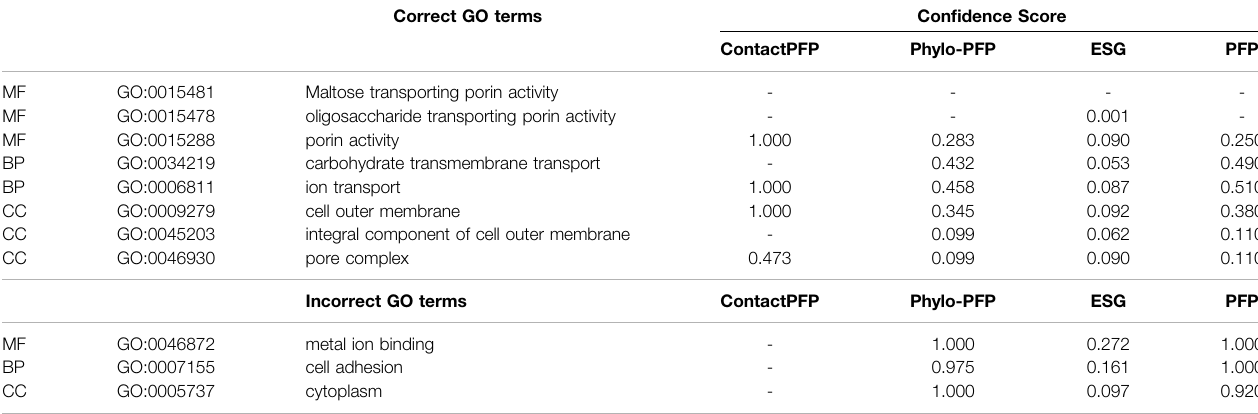
AllcorrectGOtermsassignedintheUniProtentryarelisted.ForincorrectGOterms,GOtermsthatillustratethedifferencebetweenContactPFPandtheothermethodsareshown.Scores assignedtoGOtermsbythemethodswerenormalizedbythehighestGOtermscoreforthistargetprotein.Thus,1.0meansitisthetop(i.e.,mostcon fi dent)predictionbythemethodfor this